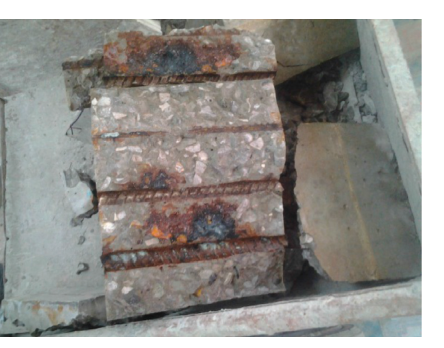
Figure 6: Specimen breakages.